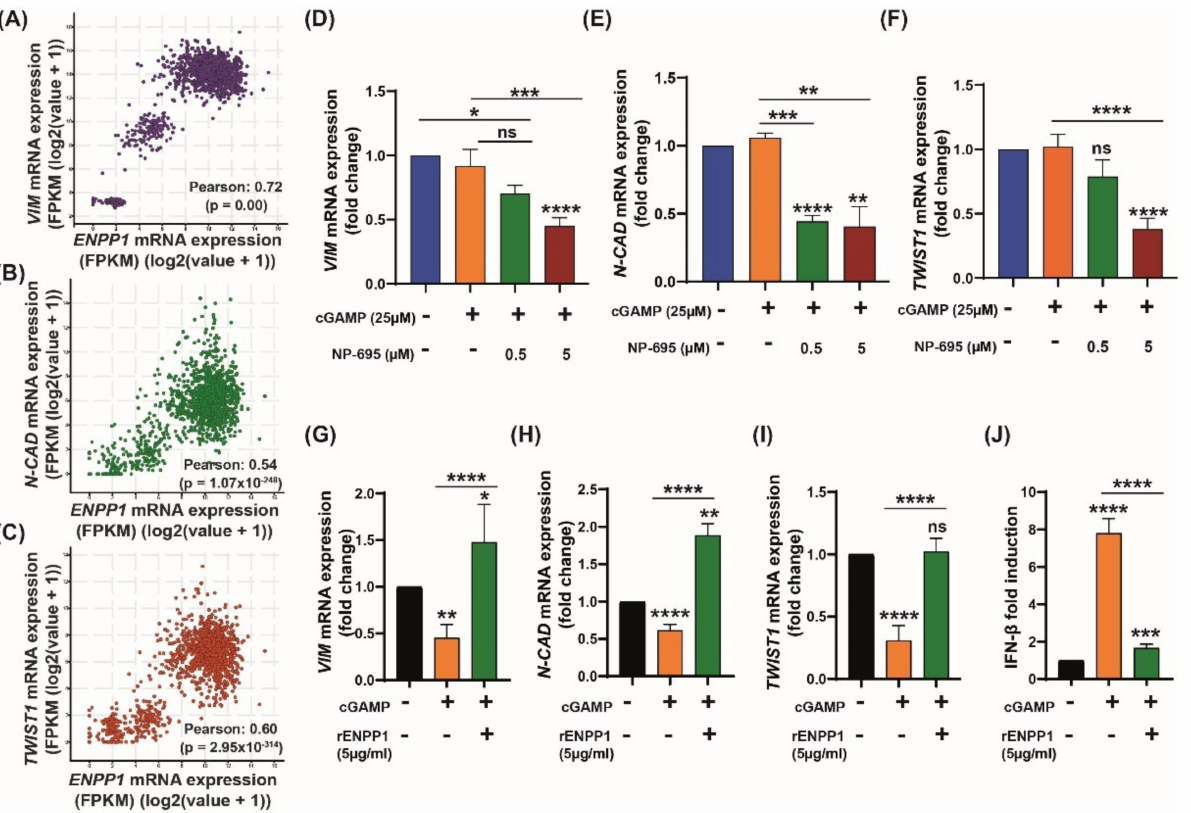
Figure 4. ENPP1 facilitates EMT by modulating 2 (cid:48) 3 (cid:48) -cGAMP levels in MDA-MB-231 and A549 Dual™ cells. ( A–C ) Pearson’s’ correlation was conducted on TCGA breast cancer data using cBioPortal. The mRNA expressions of mesenchymal markers ( A ) VIM , ( B ) N-CAD, and ( C ) TWIST1 were analyzed for their correlation with ENPP1 expression (r > 0.5, p < 0.05). ( D–F ) Effect of ENPP1 inhibitor (5 µ M) on EMT markers at mRNA level with 2 (cid:48) 3 (cid:48) -cGAMP (25 µ M) in high-ENPP1 expression MDA-MB-231 cells. ( D ) VIM, ( E ) N-CAD, and ( F ) TWIST expression was evaluated through real-time PCR and data were normalized using GAPDH (n = 3). ( G – J ) EMT markers elevated in the presence of rENPP1 in A549 Dual™ cells. rENPP1 (5 µ g/mL) along with 2 (cid:48) 3 (cid:48) -cGAMP (25 µ M) was added to A549 Dual™ cells and incubated for 24 h. mRNA levels were evaluated using RT-PCR. ( G ) VIM , ( H ) N-CAD , ( I ) TWIST1 , and ( J ) IFN- β (n = 3). The p -values were calculated with respect to the no-treatment group